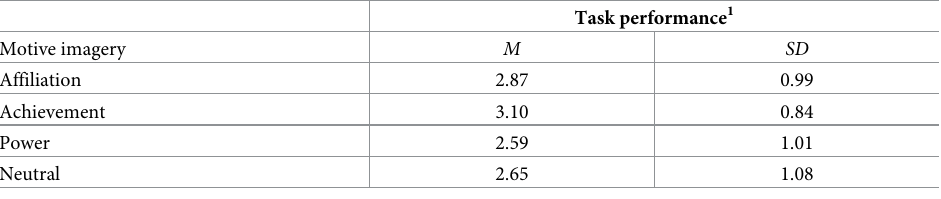
Table 4. Means and standard deviations for performance in neutral tasks and tasks related to affiliation, achieve- ment, and power in Experiment